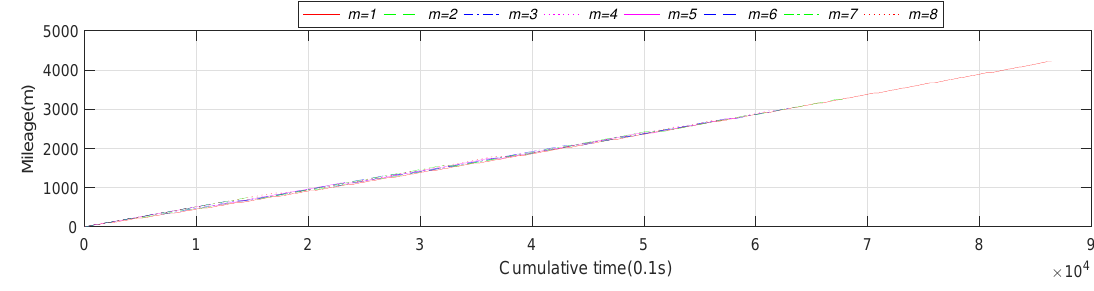
Figure 15. Total mileage comparison at different m